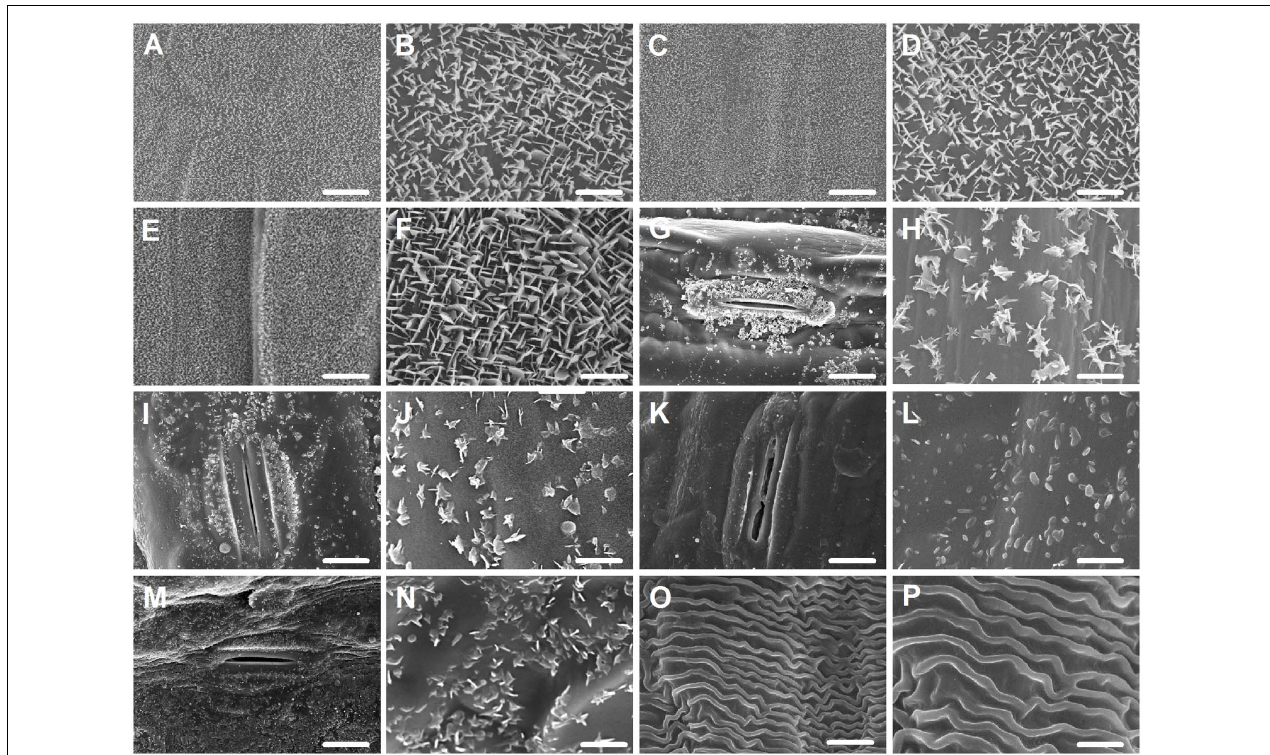
FIGURE 2 | Epicuticular wax crystals on the surfaces of various organs in Ae. tauschii detected by scanning electron microscope (SEM). (A,B) Adaxial surface of seedling leaf. (C,D) Abaxial surface of seedling leaf. (E,F) Adaxial surface of flag leaf. (G,H) Abaxial surface of flag leaf. (I,J) Leaf sheaths. (K,L) Peduncles. (M,N) Glumes. (O,P) Anthers. (A,C,E,G,I,K,M,O) Were detected at 2,000 × magnification, Scale bars = 10 µ m. (B,D,F,H,J,L,N,P) Were detected at 10,000 × magnification, Scale bars = 2 µ